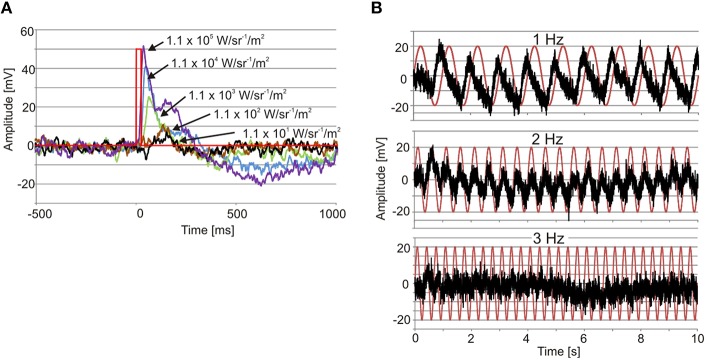
Examples of ERGs. (A) Recordings from an upper lens eye showing the graded impulse response to 25 ms flashes of light (red line) covering four log units. Note also the longer time to peak with declining light intensity. (B) Recording from a lower lens eye showing the responses to 1, 2, and 3 Hz sinusoidal light stimuli (red traces). Note that the response peaks before max intensity at 1 Hz.